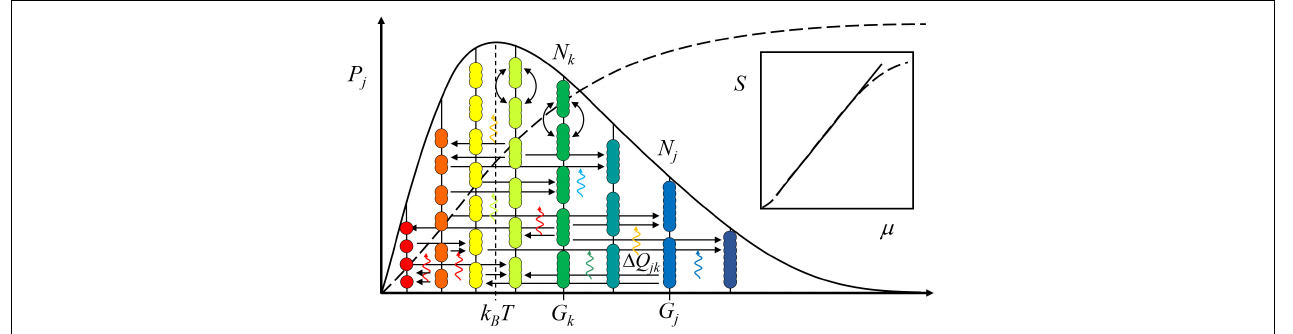
FIGURE 1 | Assuming everything comprises the same fundamental elements, the quanta, a decision-making system, as any system, can be pictured in terms of an energy level diagram. The entities in numbers N k , with the same energy G k , are on the same level. The bow arrows portray their mutual exchange, which causes no change in the average energy of the system, k B T . The horizontal arrows correspond to transformations moving the entities from one level to another. For example, in a chemical reaction, starting materials, N k , transform into products, N j . The vertical wave arrows denote the quanta of light that couple to the transformations by entering the system from the environment or vice versa. Since the quanta carry energy, (cid:49) Q jk , all events, as flows of quanta, move the system and its surroundings toward thermodynamic balance. When the surroundings are higher in energy than the system, the system evolves toward higher average energy and the surrounding systems toward lower average energy, and vice versa. The cumulative probability distribution curve (dotted line) is a sigmoid. When its logarithm, entropy, S , is plotted as a function of (chemical) potential energy, µ , it mainly follows a power law, i.e., a straight line on the logarithm-logarithm scale